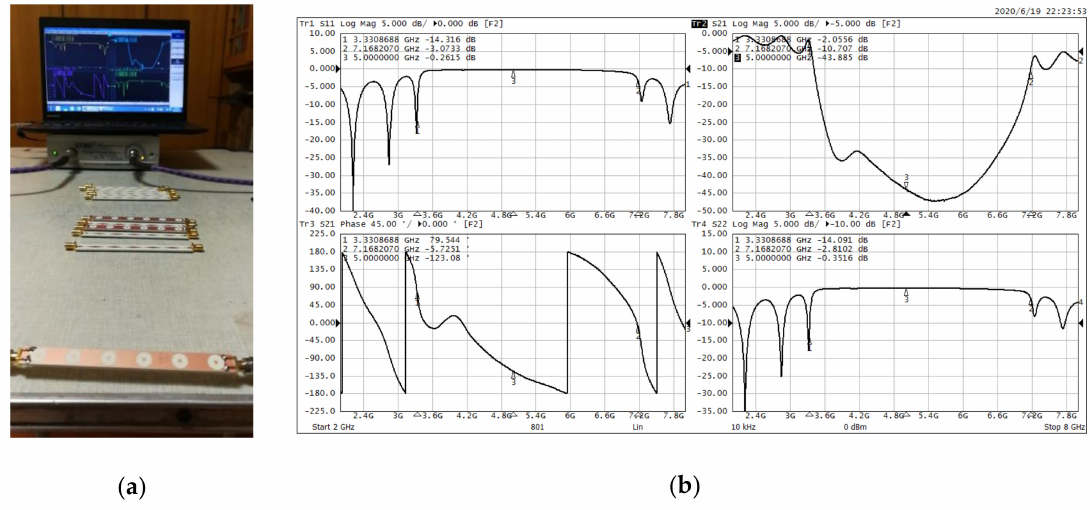
Figure 20. ( a ) Physical test photos of the band stop filter etched periodic elliptical ring EBGs; ( b ) physical measurement results of the band stop filter etched periodic elliptical ring EBGs.